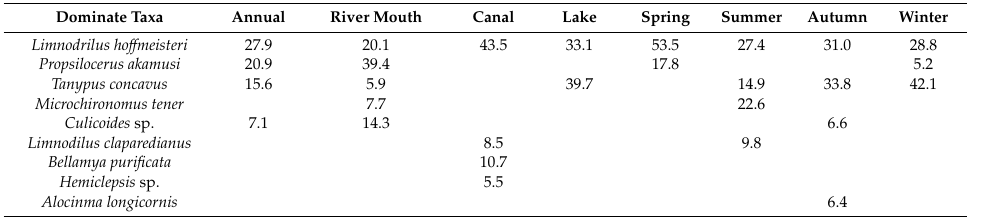
Table 2. Relative abundance (%) of dominate taxa among di ff erent research regions and seasons in Weishan